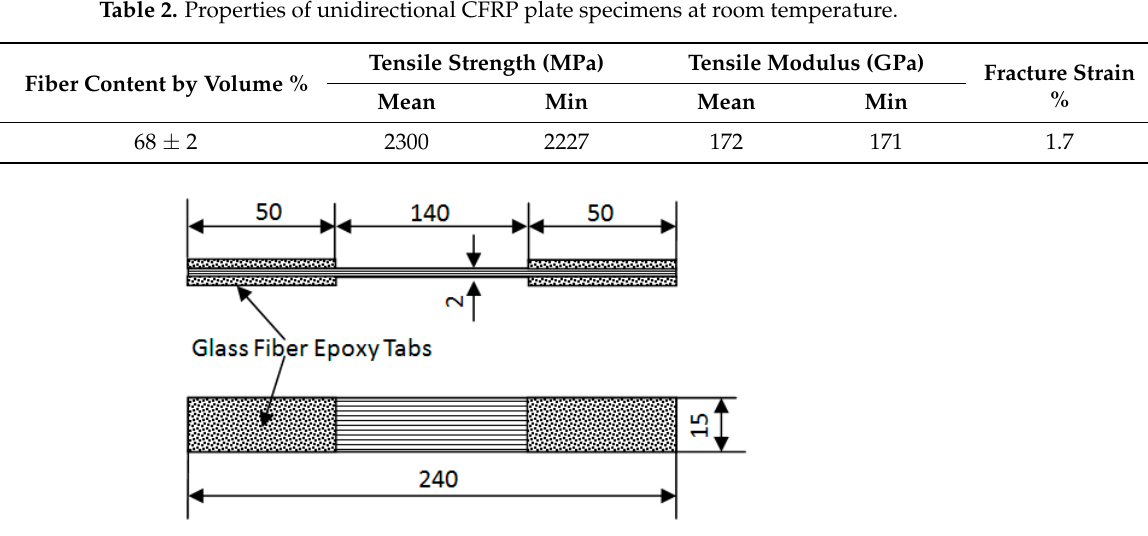
Figure 1. Schematic of tensile specimen geometry (unit: mm).